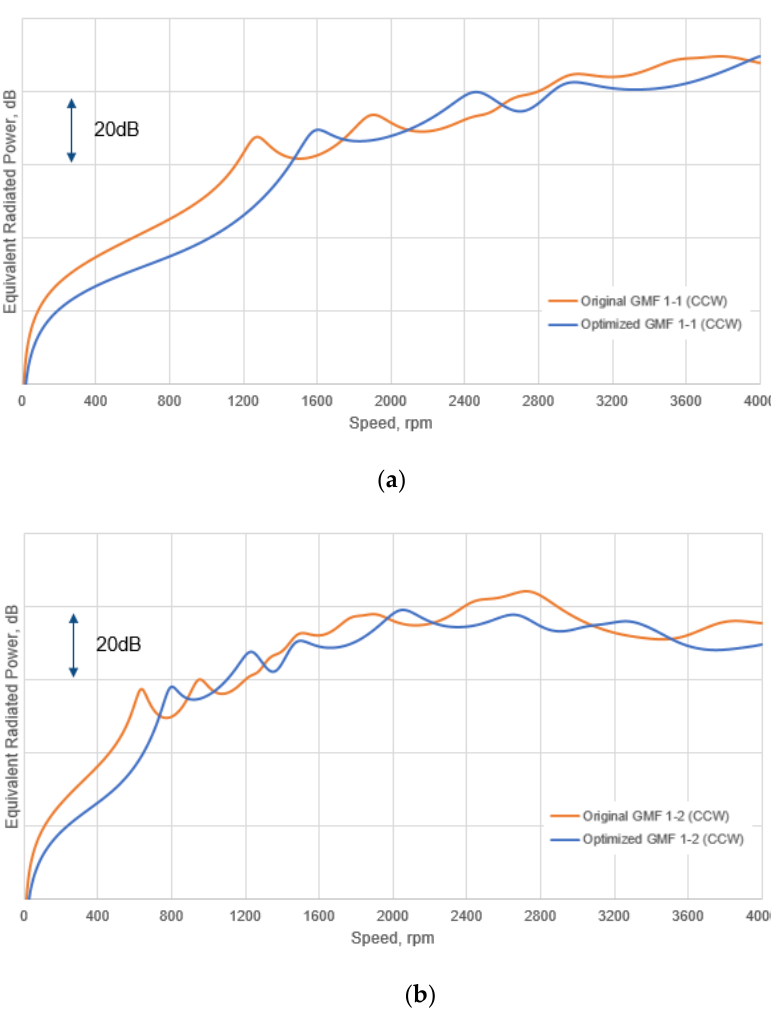
Figure 19. Equivalent radiated power comparison for counterclockwise drive. ( a ): ERP excited by gear mesh stage 1—first harmonic; ( b ) ERP excited by gear mesh stage 1—second harmonic.